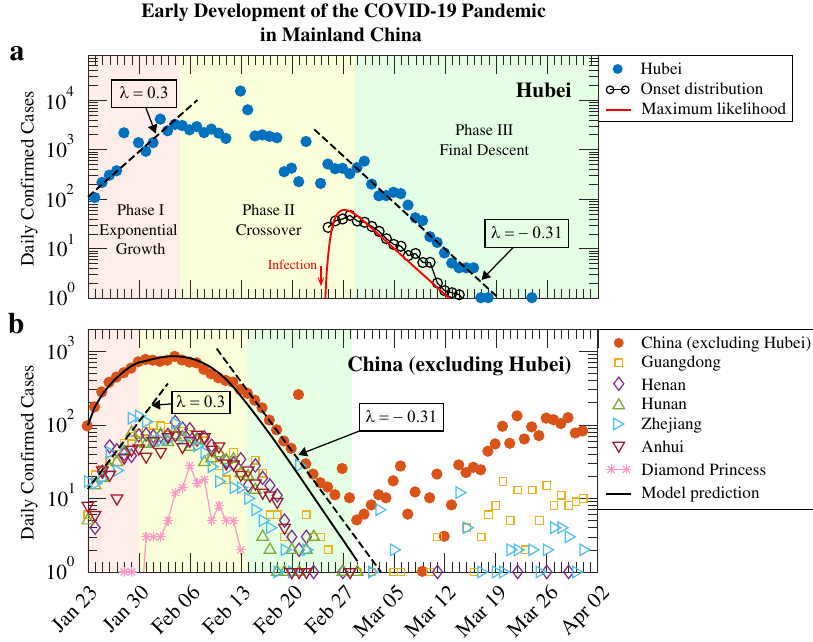
Fig. 5 Growth and containment of the COVID-19 pandemic in mainland China. Daily con fi rmed cases in Hubei and other provinces since the Wuhan lockdown on January 23, 2020. a Hubei province. The three phases of the epidemic development are shaded with different colours: exponential growth (red), crossover (yellow), and descent phase (green). Early exponential growth reached a rate λ at ~0.3/day (left dashed line). Growth slowed and entered the crossover phase in the middle of the second week, and reached the third phase nearly 4 weeks later. The fi nal descent that began in the beginning of March is characterised by λ = − 0.31/day (right dashed line). The incubation period distribution is shown in open circles (reported data of 347 cases 11,21,22 ) and red line (maximum-likelihood estimation) to compare with the exponential decay. Start of the incubation period is indicated by the red arrow. b Other provinces in China. The epidemic development in the affected provinces followed similar temporal patterns. Also shown is the model prediction of the daily con fi rmed cases (solid line), with details given in Supplementary Section 4.4. Newly con fi rmed cases from March onward (white region) are largely imported. Data for the Diamond Princess cruise ship 13 is included for comparison